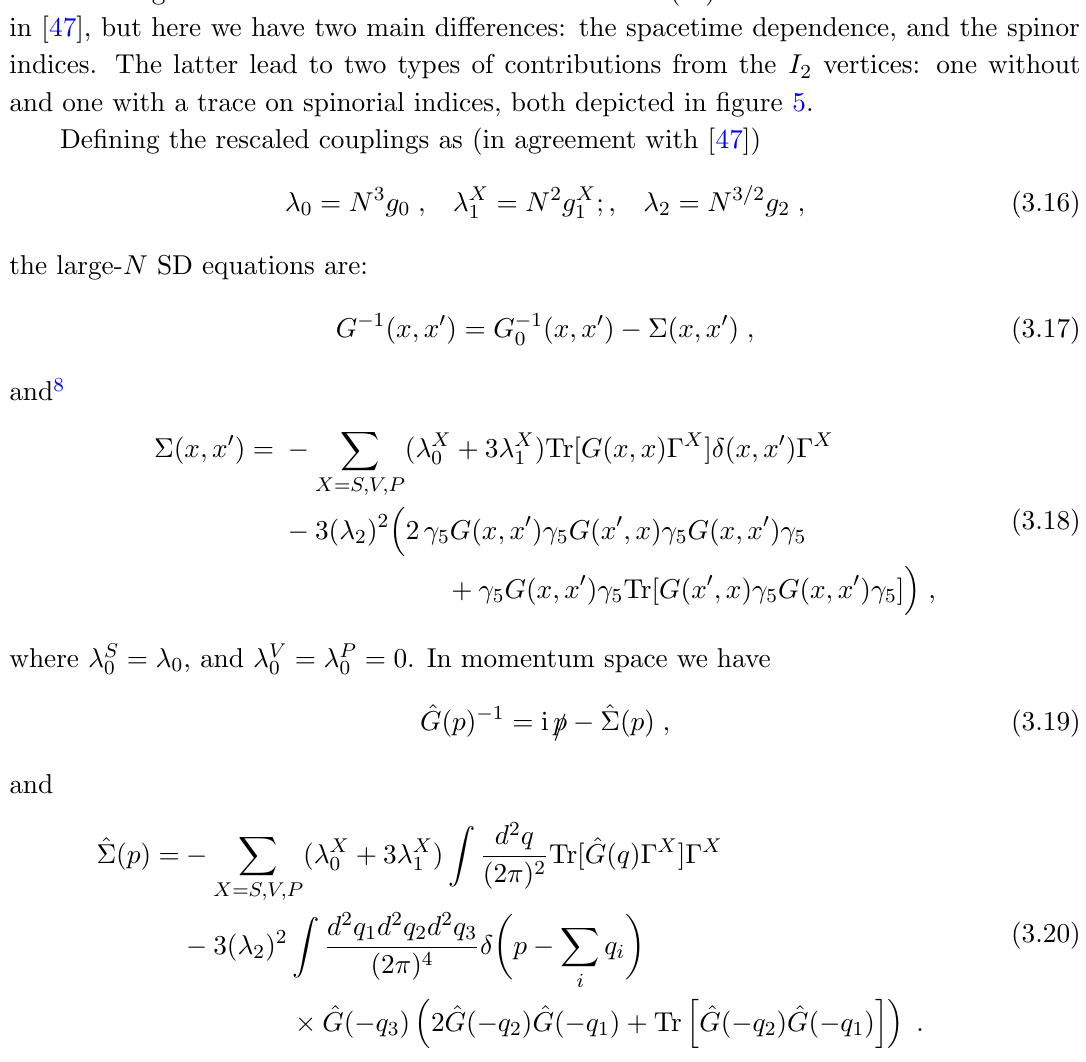
Figure 5 . Leading order contributions to the self-energy resulting from interactions of type I graph on the left involves a trace over the spinorial indices, while the graph on the right does